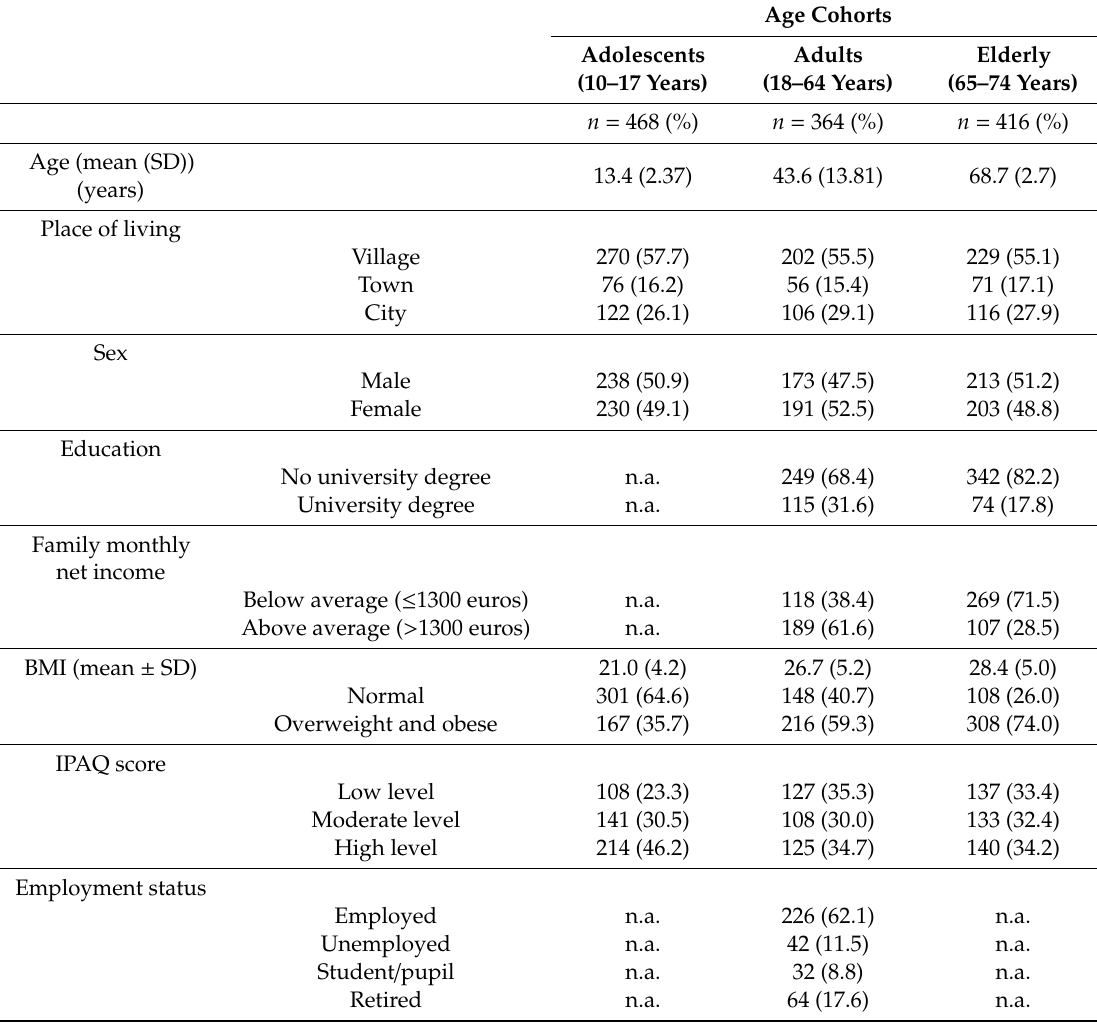
Table 1. Demographic characteristics of the study